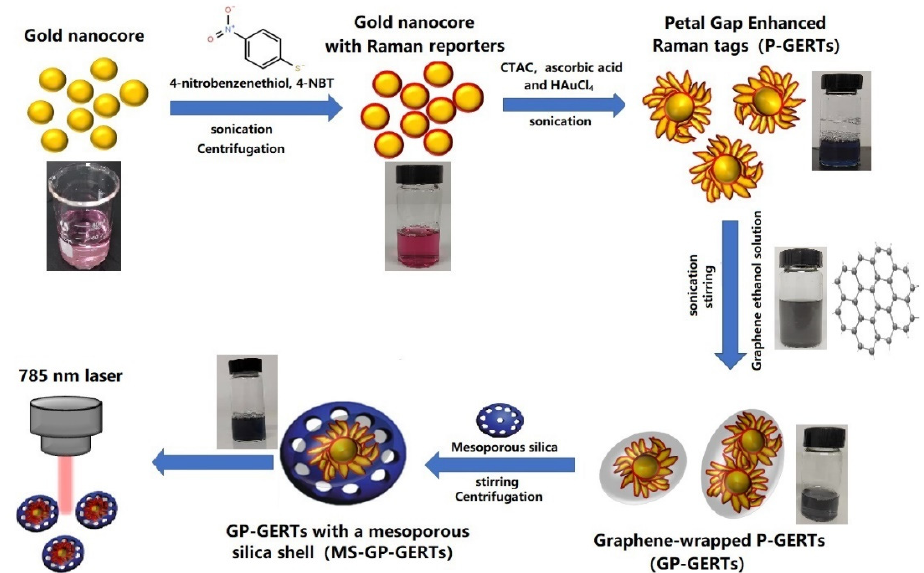
Figure 1. Schematic illustration of the synthesis process of the GP-GERTs and MS-GP-GERTs and SERS measurement by Raman system.